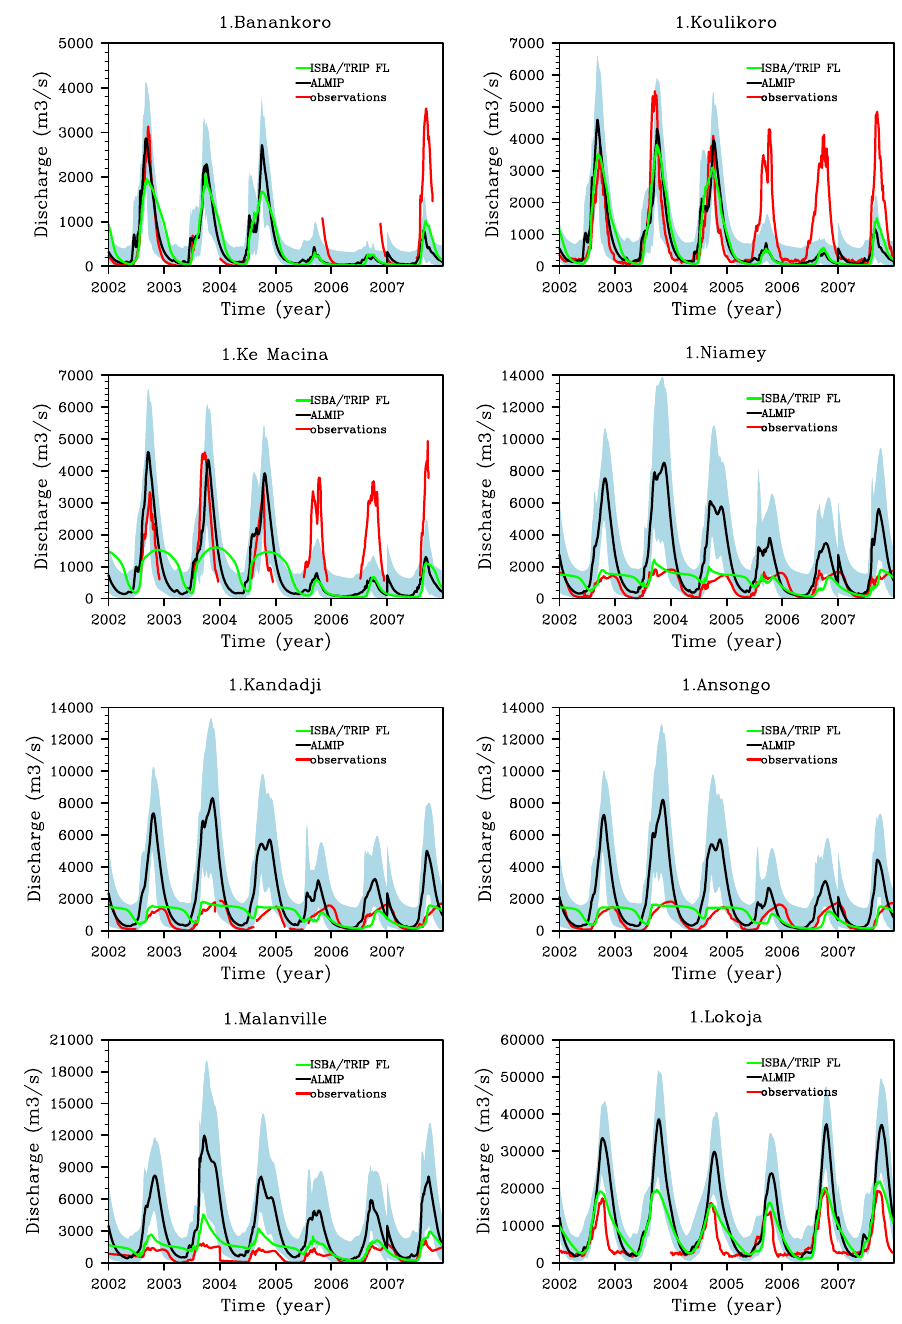
Fig. 4. Daily discharges (2002–2007) simulated by ALMIP LSMs without floods (average, black line) and by ISBA-TRIP using the flooding scheme (green). Observations are in red and the blue range is limited by the minimum and maximum discharge simulated by LSMs. The TRMM-3B42 rain product is used as forcing